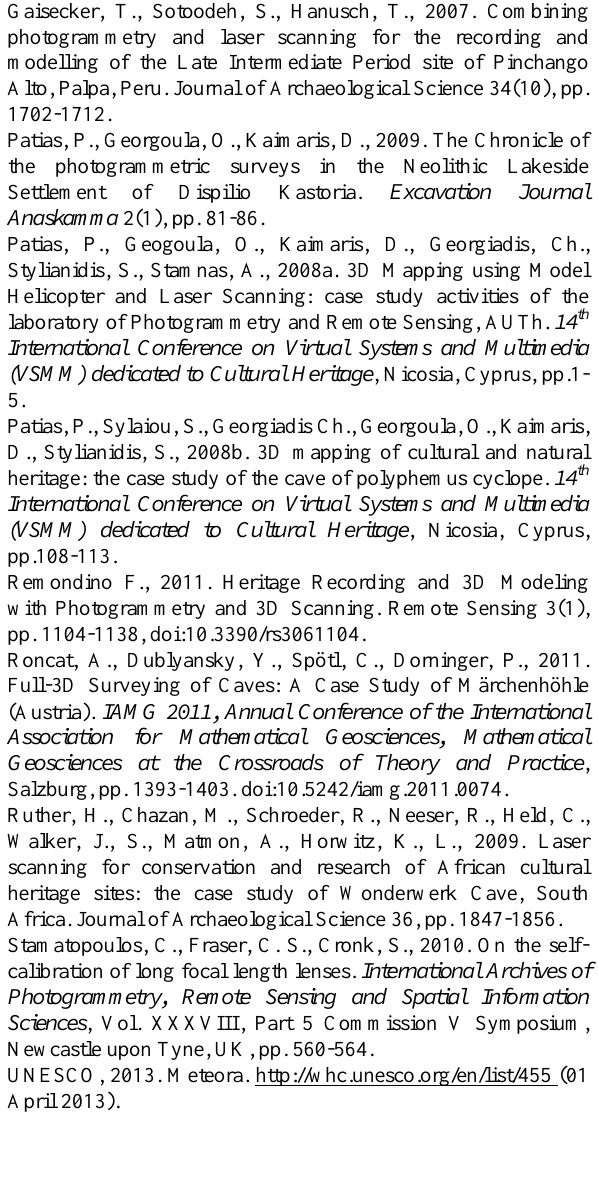
Figure 20.a. West face of section B.